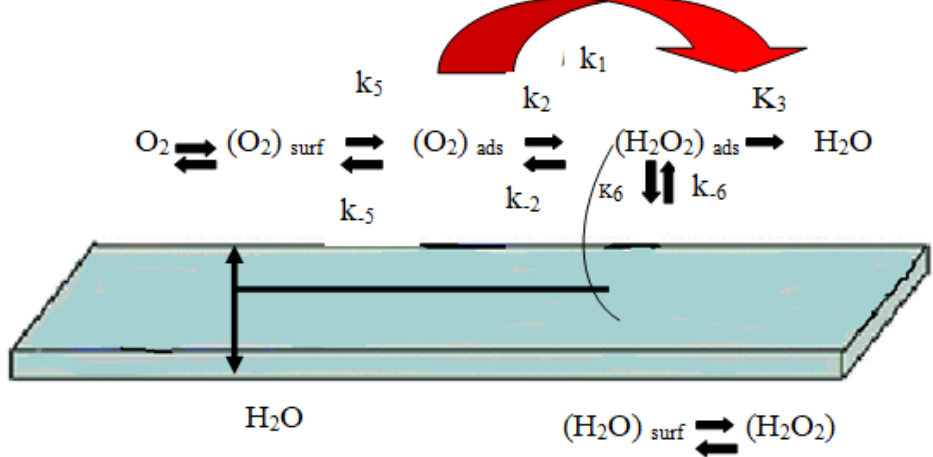
Figure 8. Mechanism of oxygen reduction reaction on the surface of electrode.